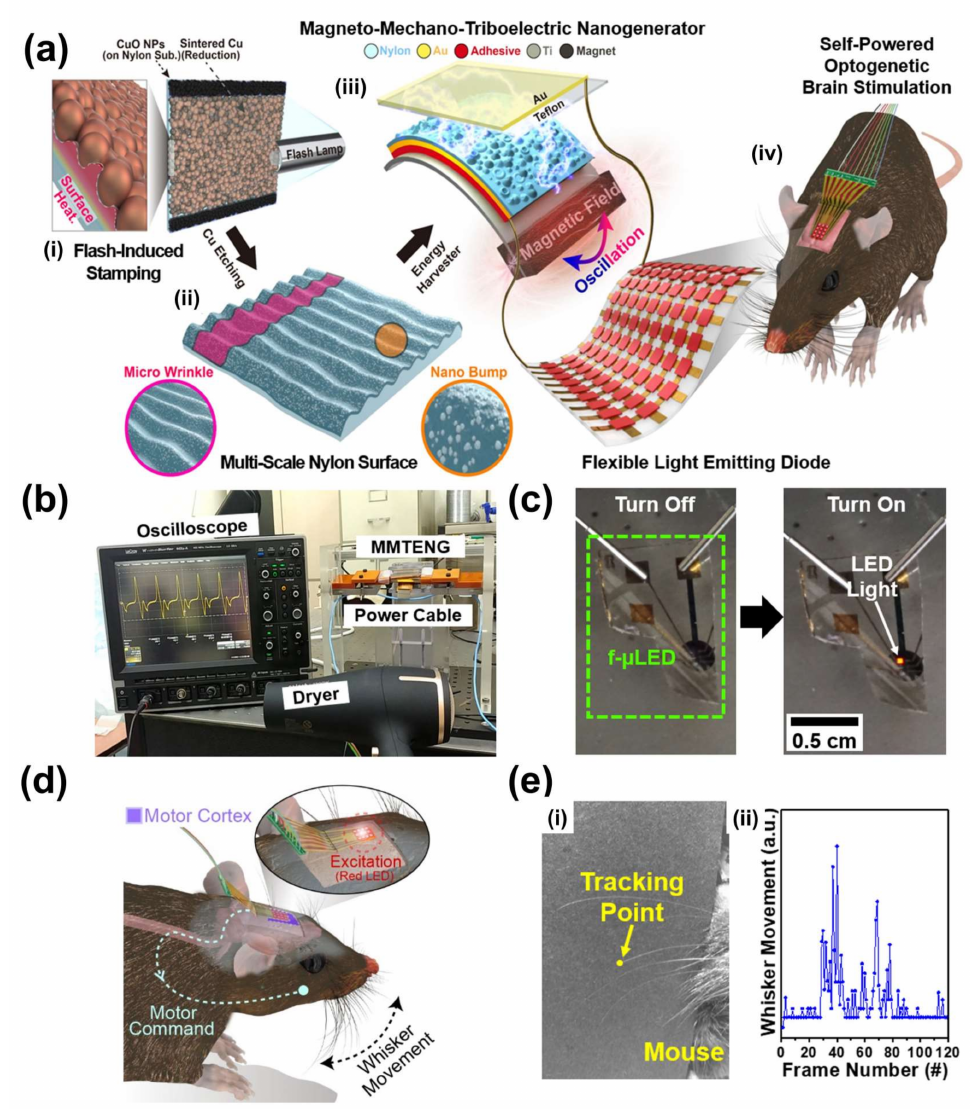
Figure 10. ( a ) Schematic illustration of the fabrication process for MMTEG and its application for optogenetic neuromodulation. ( b ) Photograph image of MMTEG to generate electric energy near power cable of home appliance. ( c ) Photograph of f- µ LED turning on by MMTEG. ( d ) Schematic illustration of optogenetic neuromodulation under skull of mouse. ( e ) Video tracking point of optogenetic neuromodulation ( i ) and whisker movement during the procedure ( ii ). Reproduced with permission